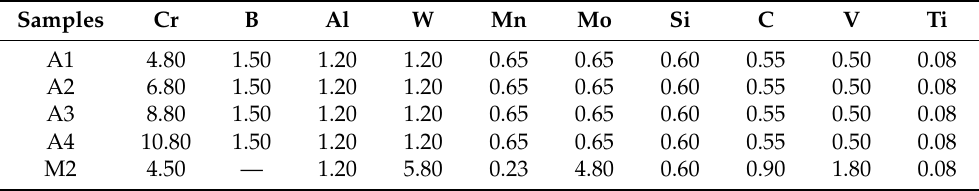
Table 1. Chemical compositions of cast high-boron high-speed steel analyzed by spark emission spectrometer